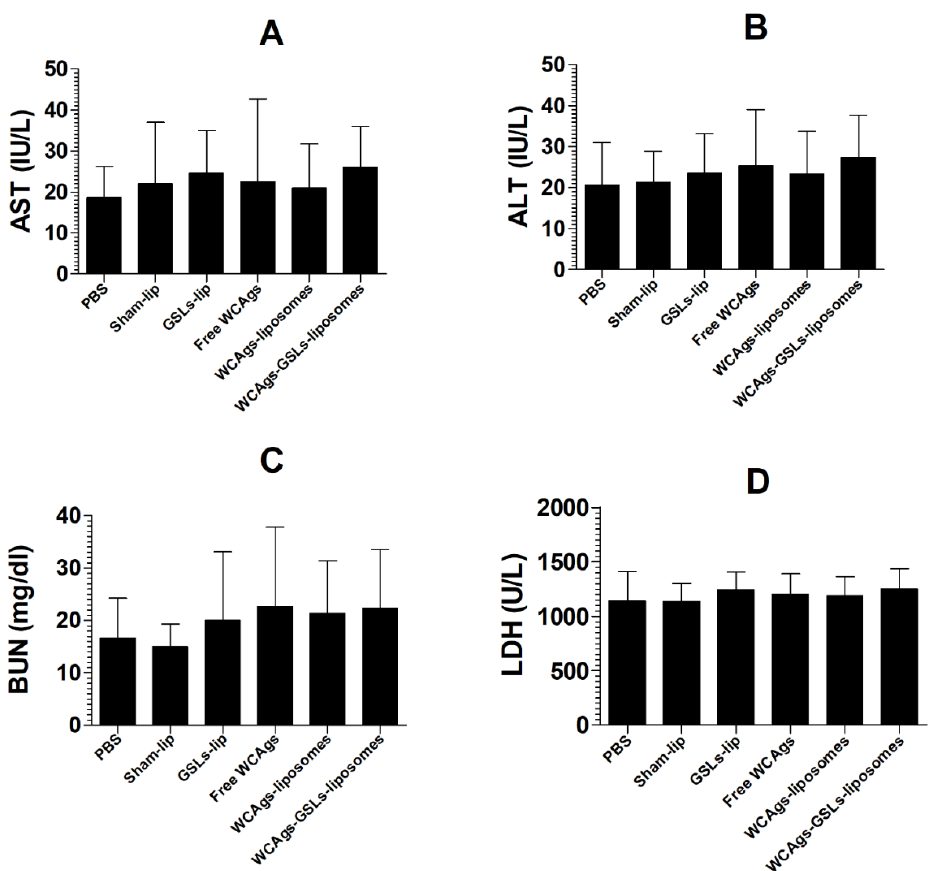
Figure 3 . WCAgs-GSLs-liposomes did not induce any toxicity in mice. On day 5 post-final booster dose, the blood was collected to analyze the levels of ( A ) AST, ( B ) ALT level, ( C ) BUN, and ( D ) LDH. The data are presented as the mean ± SD of two different experiments.